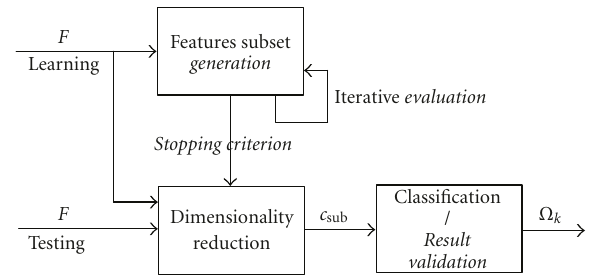
Figure 3: Feature selection principle with the four major parts generation , evaluation , stopping criterion , and result validation as described by